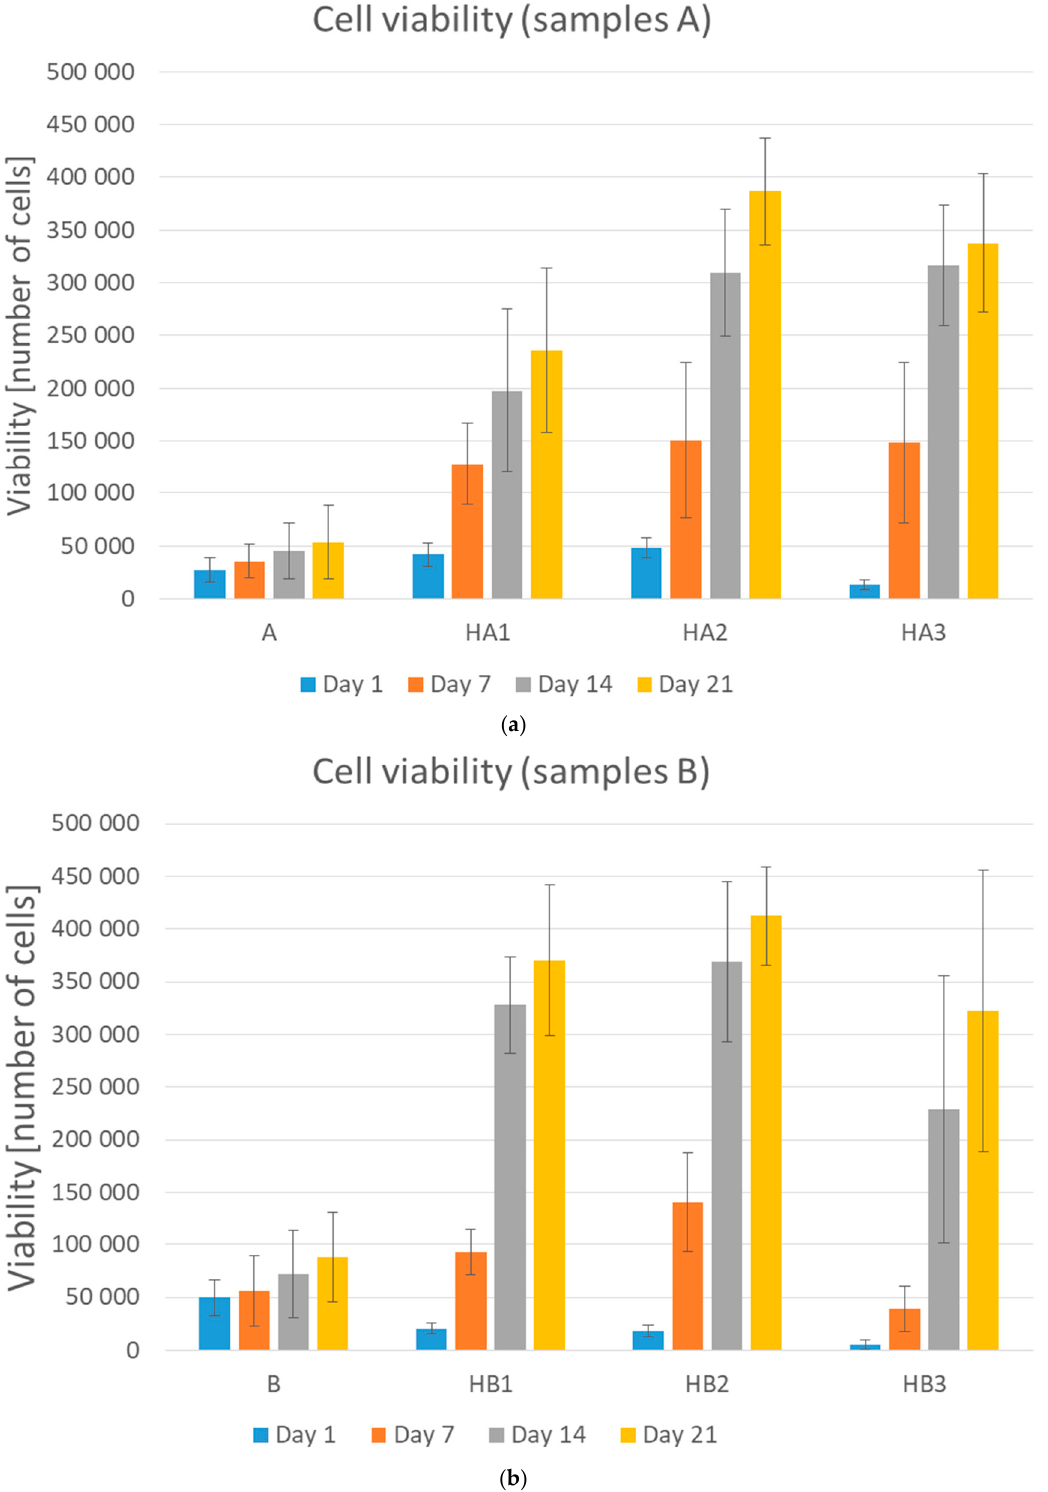
Figure 2. Graphical representation of cell viability (adhesion—day 1, proliferation—day 7, 14, and 21). ( a ) Samples A, HA1, HA2, and HA3 and ( b ) samples B, HB1, HB2, and HB3. Error bars represent ±SD. A: PVA/HA = 3:1; HA1: PVA/HA/Hap = 3:1:1; HA2: PVA/HA/Hap = 3:1:2; HA3: PVA/HA/Hap = 3:1:3; B: PVA/HA = 1:1; HB1: PVA/HA/Hap = 1:1:1; HB2: PVA/HA/Hap = 1:1:2; HB3: PVA/HA/Hap = 1:1:3.